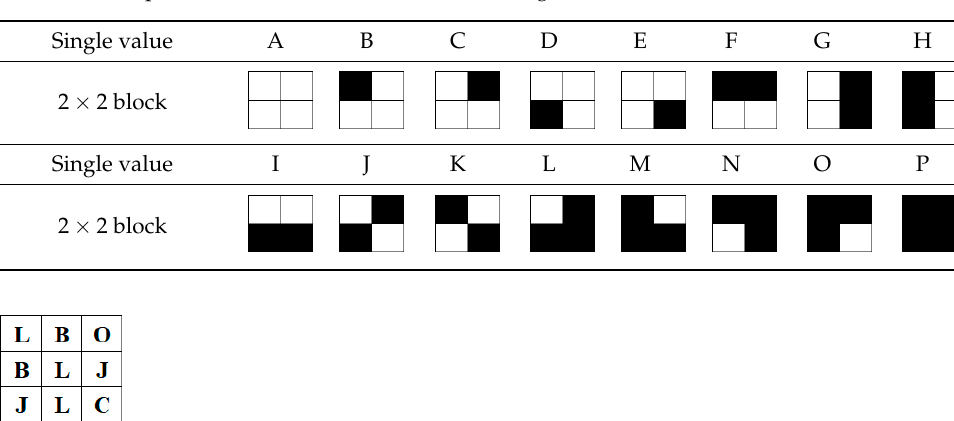
Table 1. Correspondence between 2 × 2 blocks and single values.